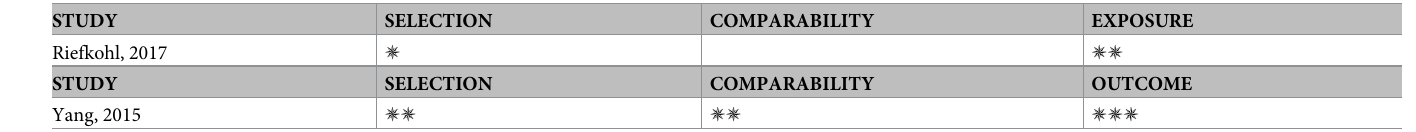
Table 3. Risk of bias